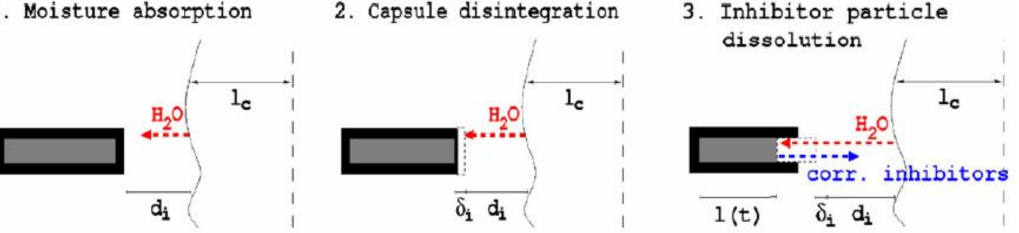
Figure 11. Modelling of the different steps of the nanocontainers’ release. Reprinted with permission from Ref. [49]. Copyright 2012,